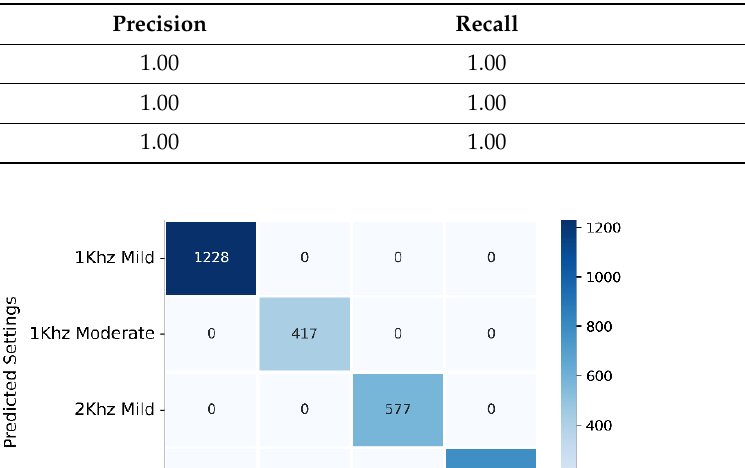
Table 3. Preset and subset selection accuracy of RF.